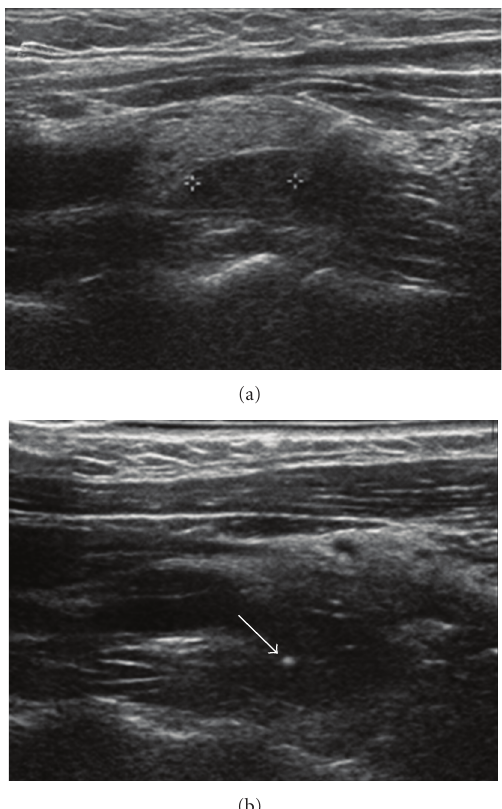
Figure 1: (a) Ultrasound of parathyroid adenoma. (b) Same patient, with guide wire in place (white